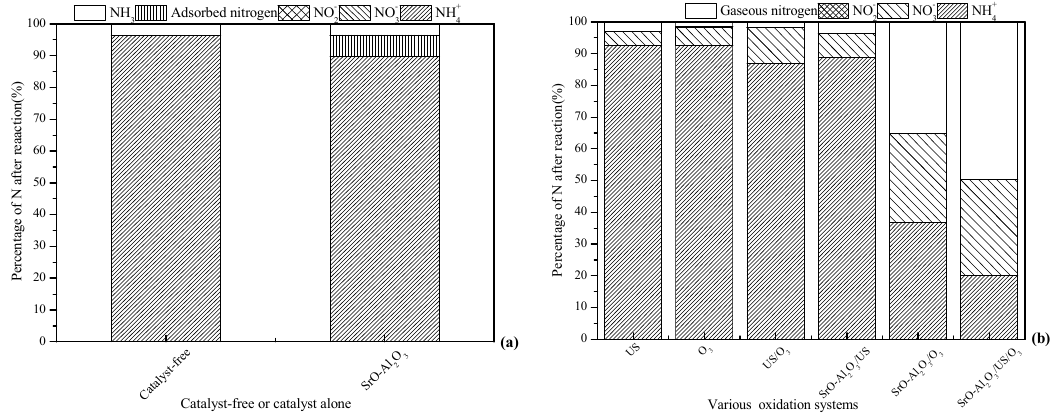
Figure 2. Performance comparison in the various treatment systems on ammonia conversion. Reaction conditions: initial NH 4 + concentration 50 mg / L, initial pH 8.5, ozone flow 1.5 g / h, catalytic dosage 2.0 g / L, reaction temperature 25 ◦ C, reaction time 60 min, ultrasonic frequency 25 kHz, ultrasonic power 270 W, ultrasonic operation 1 s and interval 2 s. ( a ) Catalyst-free or catalyst alone; ( b ) various oxidation systems.